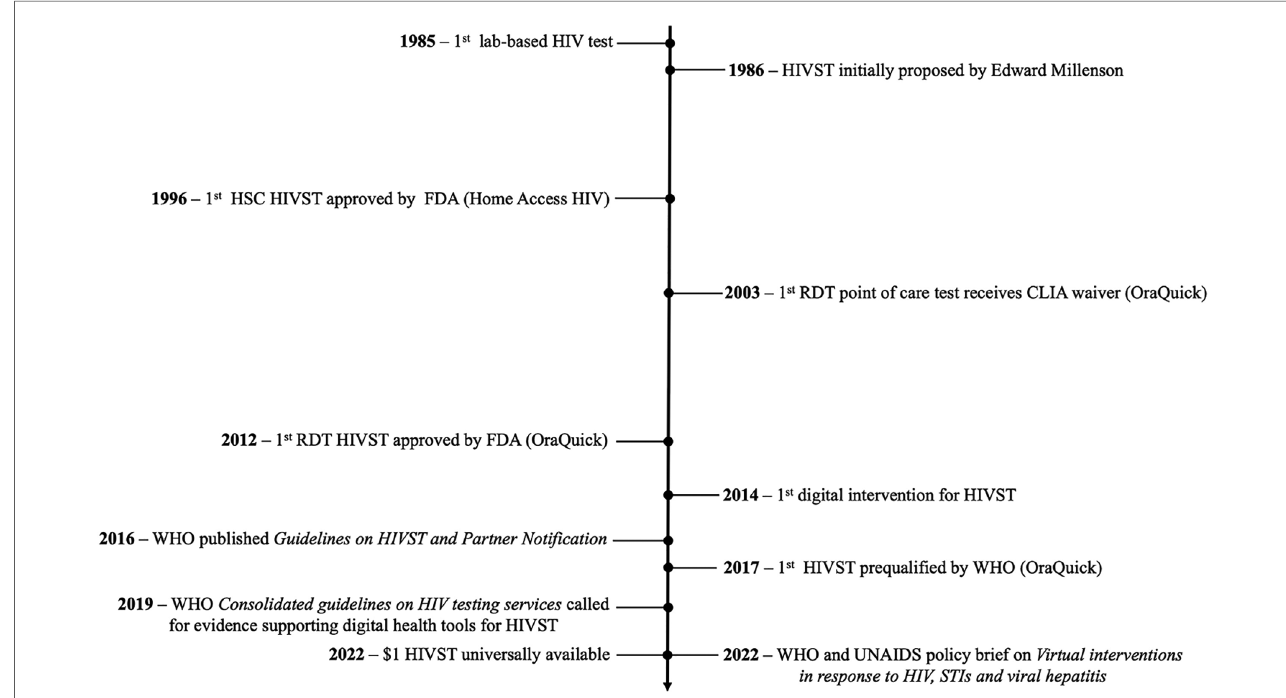
FIGURE 1 TimelineofHIVSTanddigitalinterventionsforHIVST.FDA,UnitedStatesFoodandDrugAdministration;HIV,humanimmunode fi ciencyvirus;HIVST,HIVself-testing; HSC, home sample collection; STI, sexually transmitted infection; UNAIDS, The Joint United Nations Programme on HIV/AIDS; WHO, World Health